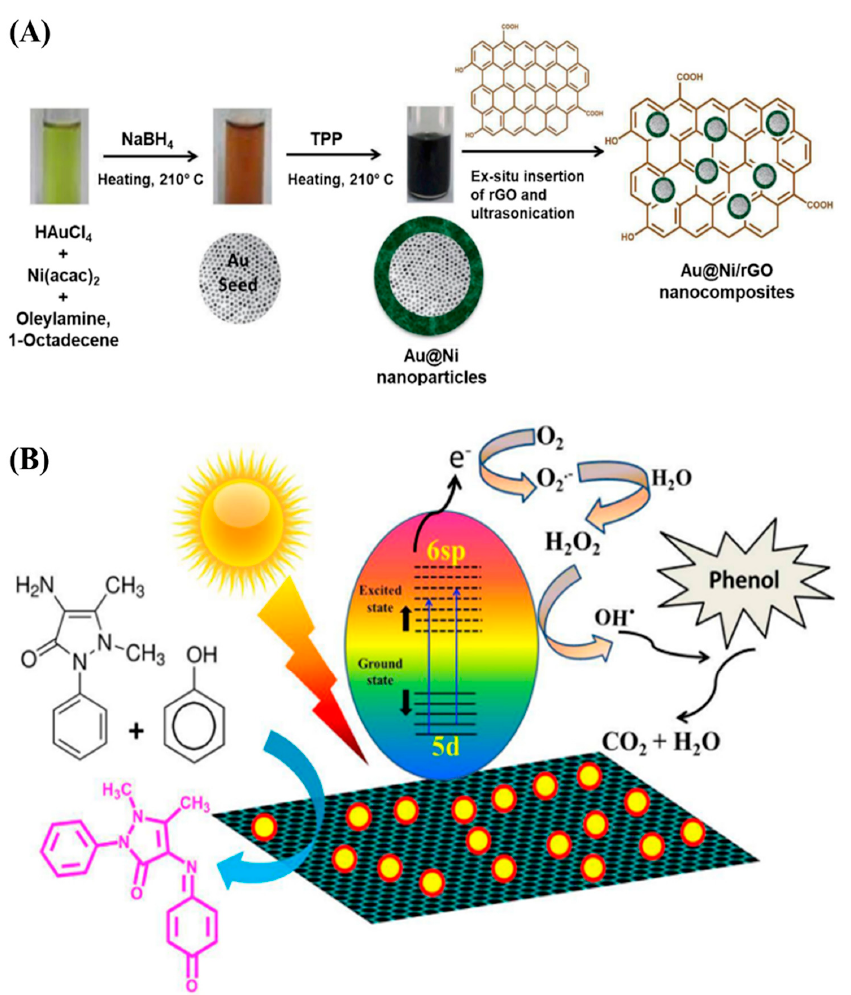
Figure 3. ( A ) Schematic diagram of Au@Ni/rGO-based colorimetric detection and degradation of phenol. ( B ) Schematic diagram of mechanism of core–shell nanocomposite-assisted colorimetric detection of phenol. Adapted from [72].